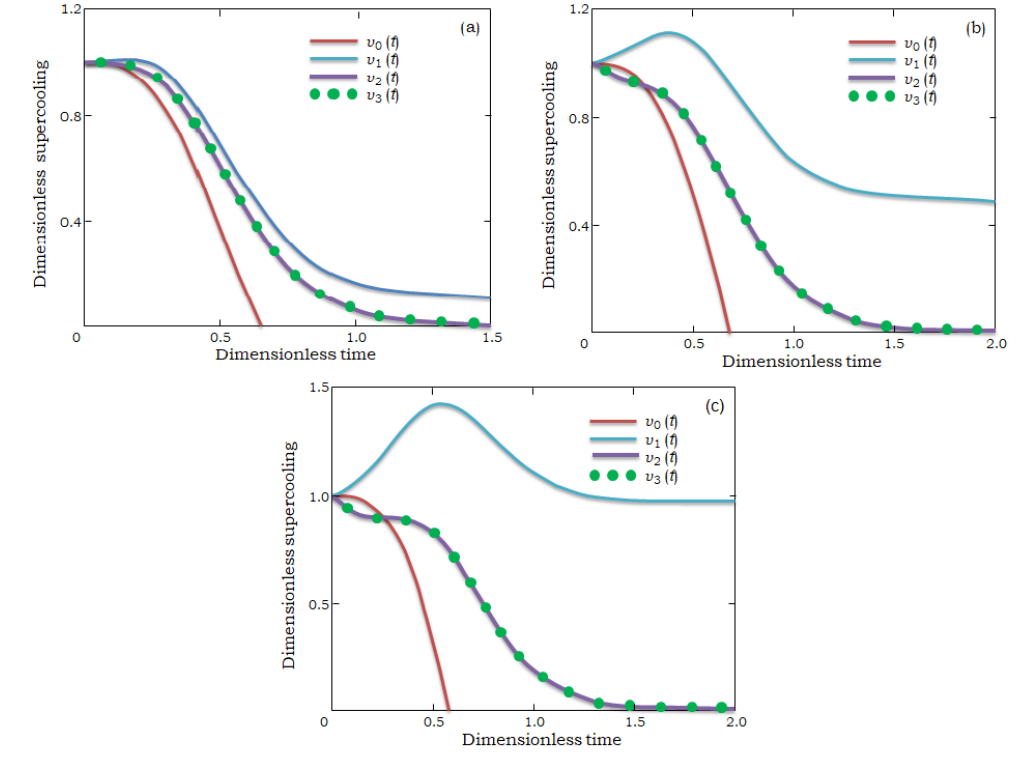
Figure 1. Dimensionless supercooling υ = ∆ T ∆ as a function of dimensionless time t = τ : ( a ) WVFZ τ 0 T 0 kinetics at ∆ T 0 = 373 K, p = 66.9; ( b ) WVFZ kinetics at ∆ T 0 = 573 K, p = 7.4; ( c ) Meirs kinet- ics at ∆ T 0 = 573 K, p = 4. The physical parameters are typical for supercooled melts [52–54]: γ i = 0.3 J m − 2 , L V = 7 × 10 9 J m − 3 , T p = 1273 K, ρ s = 7.8 × 10 3 kg m − 3 , ρ m = ρ l = 7 × 10 3 kg m − 3